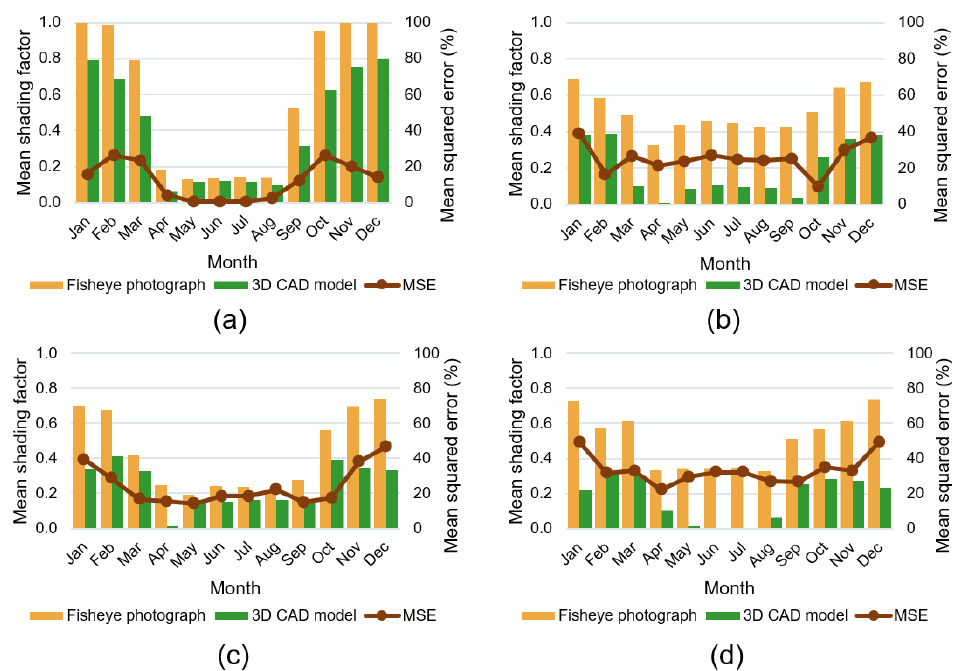
Figure 14. Mean shading factors for each month at survey points ( a ) B1, ( b ) B2, ( c ) B3, and ( d )